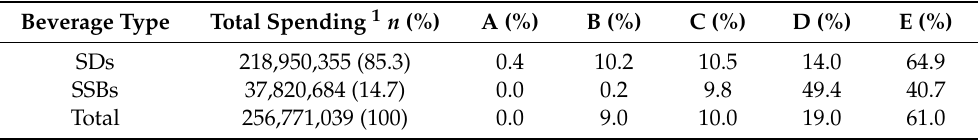
Table 2. Nutri-score classification of the advertising spending by the 10 top companies in soft drinks and sugar-sweetened beverages in Spain by category (2013–2018).